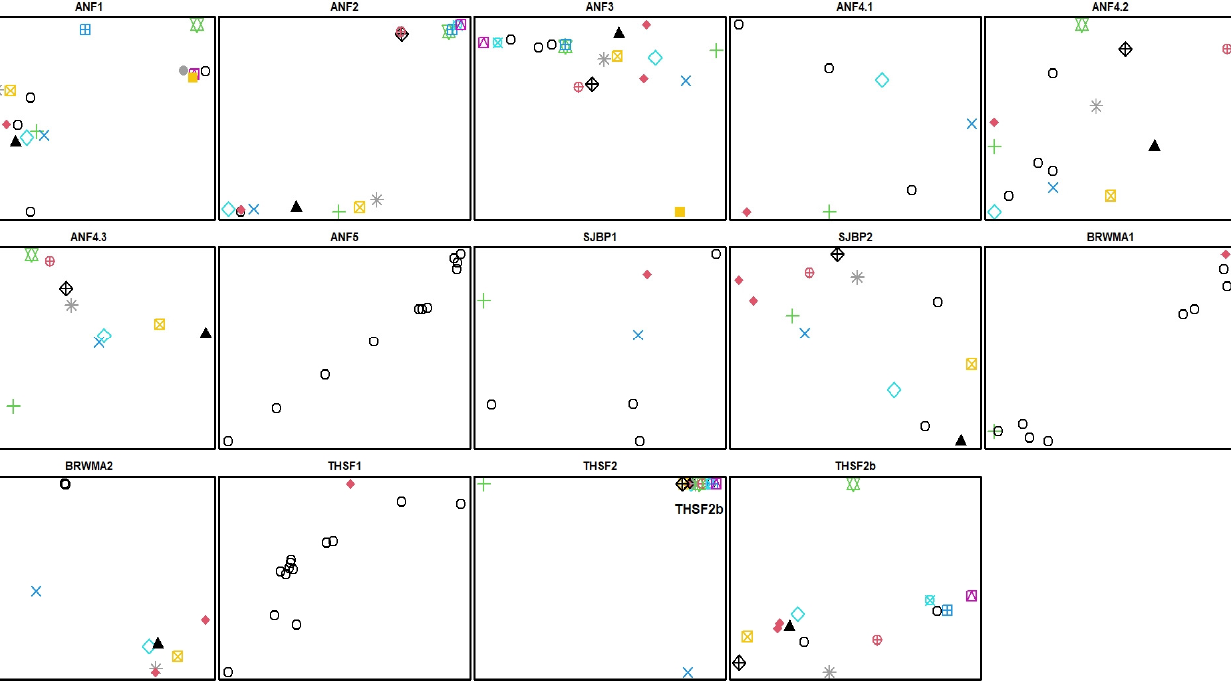
Table 2. Estimation of the number of unique clones (genotypes), ramets, and clonal richness per S. floridana population. N = sample size. Fifth column reports the number of ramets per clone (fre- quency in parentheses). CR = clonal richness, CR = (G − 1)/(N − 1) (49). Clonal analysis for ANF4 was divided among three sampling sites because of its broad spatial distribution. n/a = no gap in the histogram to allow for a threshold designation for clones; for these populations, the minimum pair- wise diversity was ≥ 0.04.